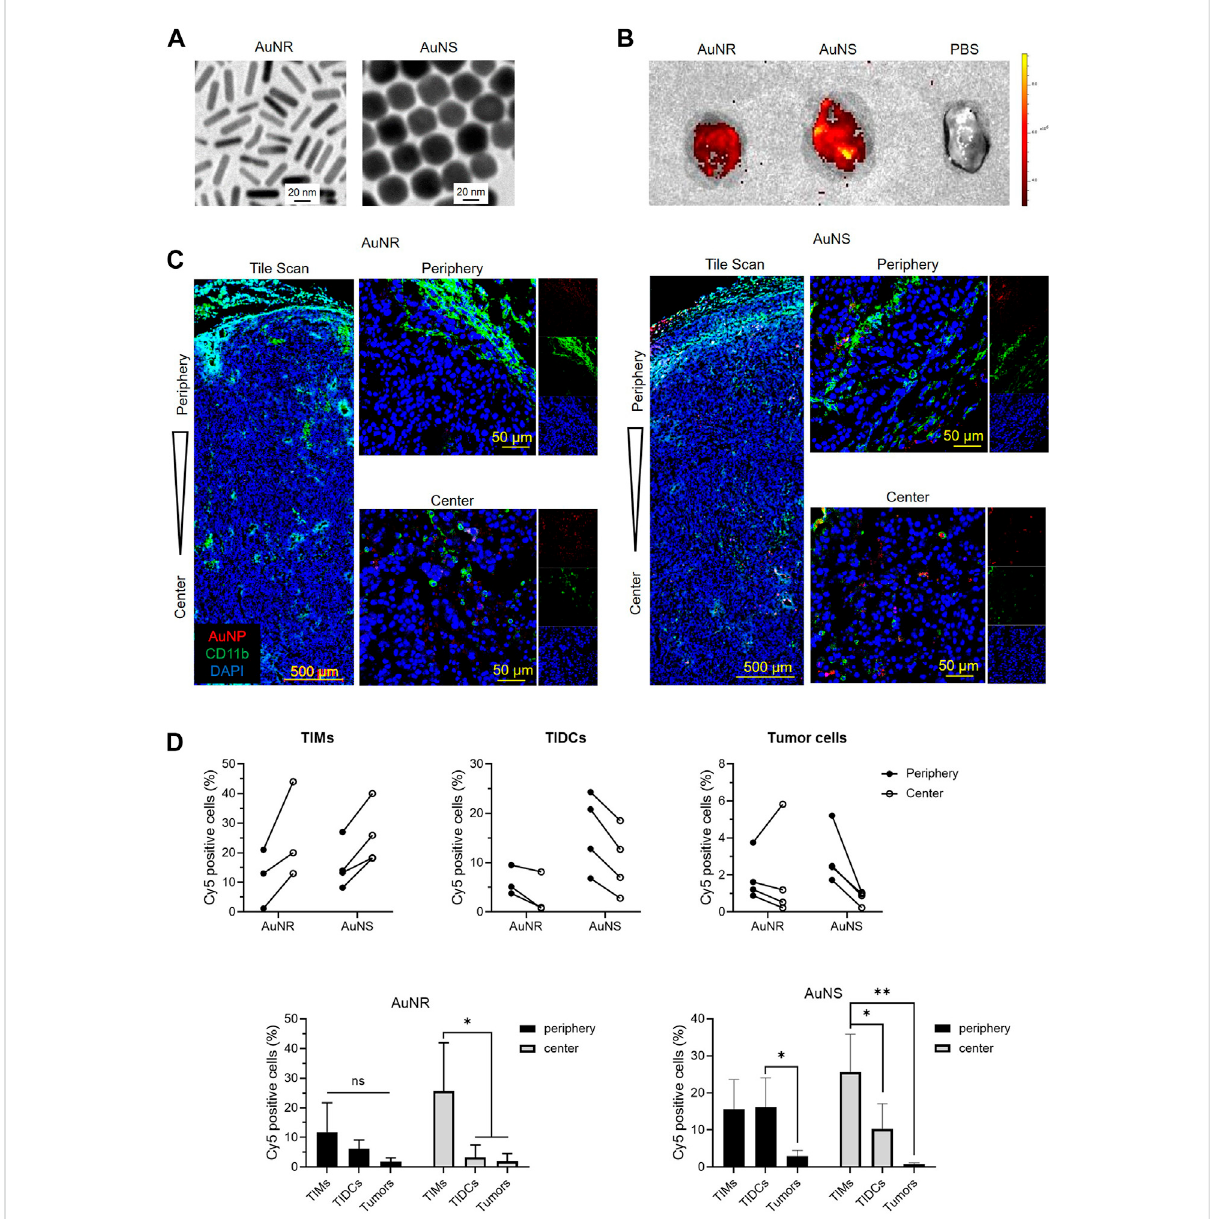
FIGURE 2 The TIMs and TIDCs affect the distribution of nanoparticles within tumors. (A) Representative oftransmission electronic microscopic images of AuNR and AuNS. The scale bar is 20 nm. (B) Fluorescent images of B16 tumors harvested at 24 h after intravenously injection of PBS, Cy5-AuNR or Cy5-AuNS. (C) CLSMimagesshowthetilescanimagesofperipheryandcenterofB16tumorschallengedwithCy5-AuNRorCy5-AuNS(red).Tumor- in fi ltrating myeloid cells were stained with CD11b-PE (green). Cell nuclei were stained with DAPI (blue). (D) Cellular uptake of Cy5-AuNR and Cy5-AuNS by TIMs, TIDCs or tumor cells in the periphery or center region in B16 tumors measured by fl ow cytometry (top panel). Statistical analysis of Cy5 positive cells of TIMs, TIDCs or tumor cells (bottom panel). The scale bar is 500 μ m (tile scan) or 50 μ m (ampli fi ed images of periphery and